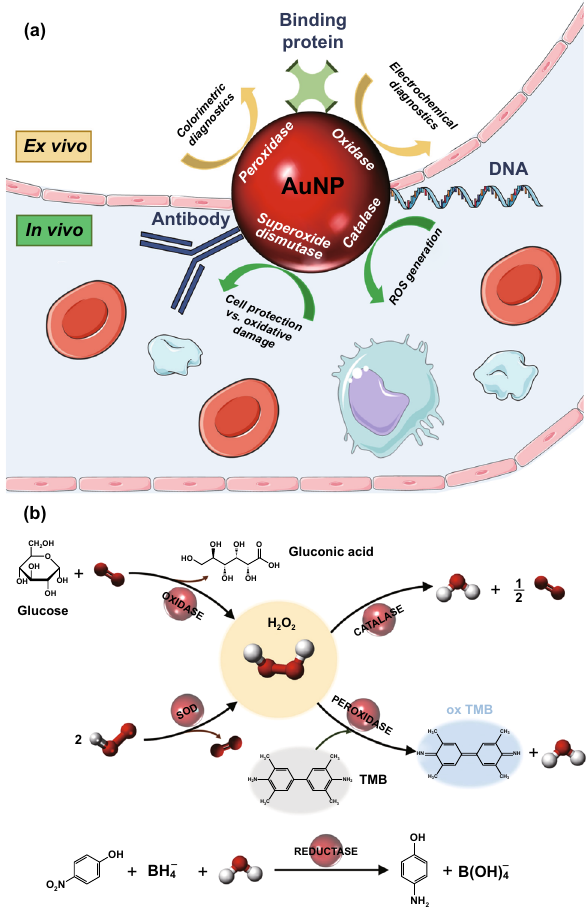
Fig. 6 a Summary of the different catalytic activities of AuNPs mainly used in biomedical applications. b A description of these activities with a representative